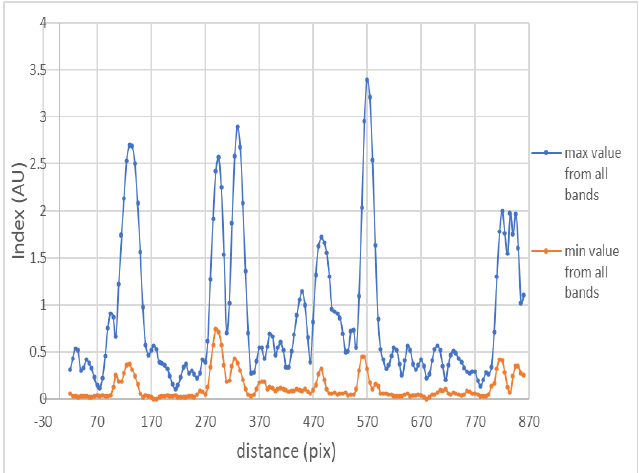
Figure 3: Minimum and maximum variance in a spatial